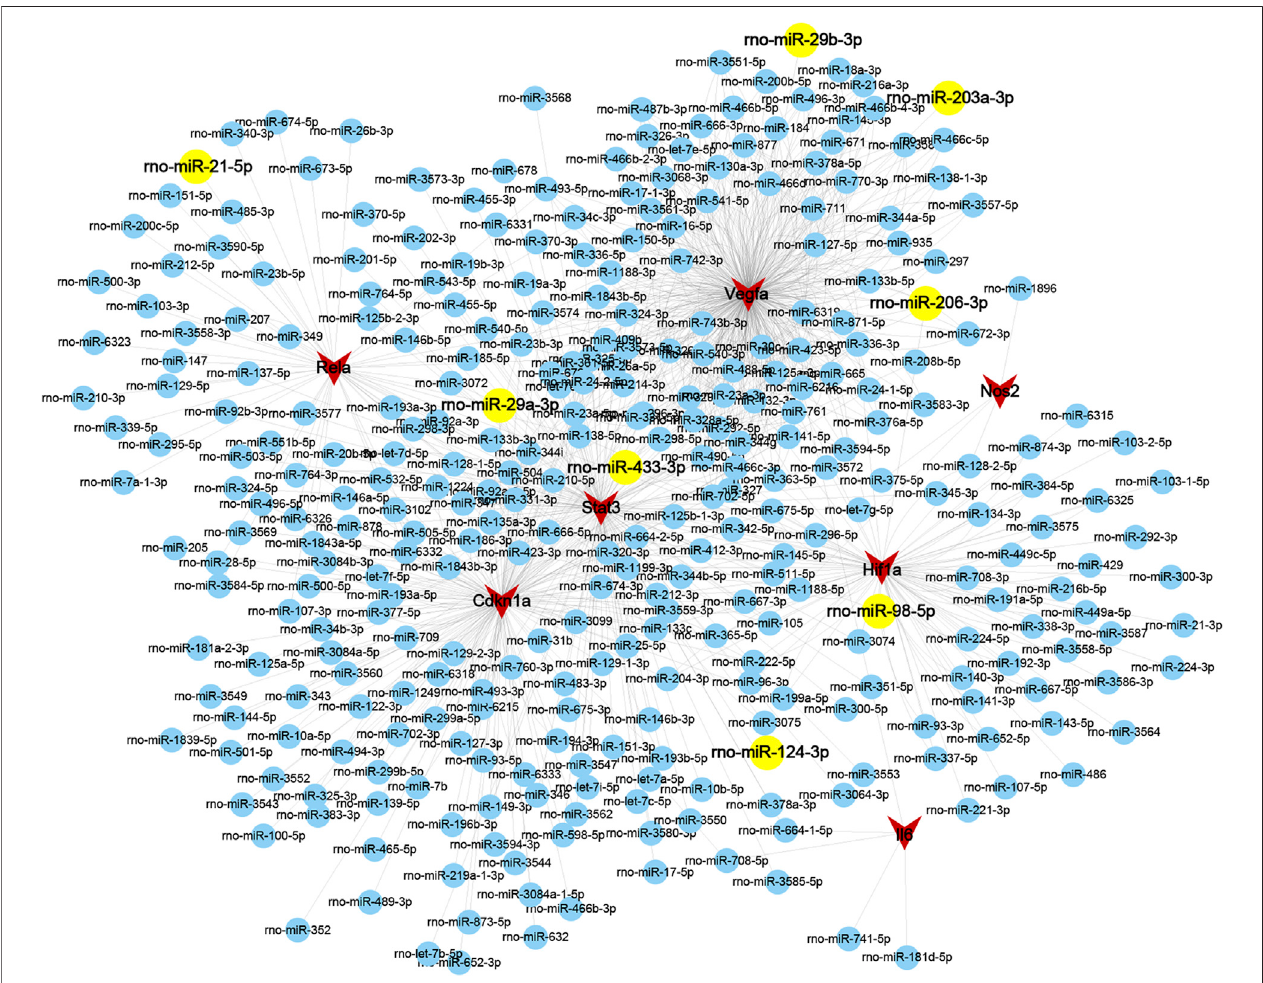
FIGURE7| Interactiongene-miRNAsnetworkofferroptosisDEGsrelatedtotheHIF-1signalingpathwayinCluster1.GenesandmiRNAsarepresentedascircular nodes (both in blue and yellow) and triangular nodes in red, respectively, and the miRNAs predicted by the miRTarBase database are colored in yellow. Abbreviations: DEGs, differentially expressed